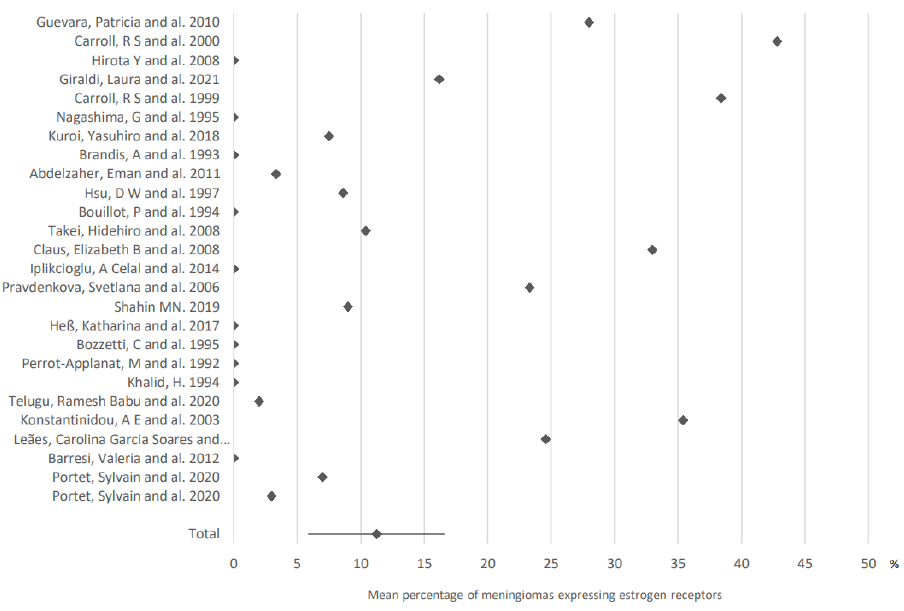
Figure 2. Expression of estrogen receptors in meningiomas. The results are expressed as a mean associated with their 95% confidence interval. Number of articles analyzed related to the topic: 26. Number of included cases (total for all studies; minimum; maximum in each study): 1528 (21; 161). After analysis of data from seven related articles, androgen receptors (AR) expression was found in 45.5% of meningiomas (95% CI: 23 – 68). These results are presented in Figure 3.